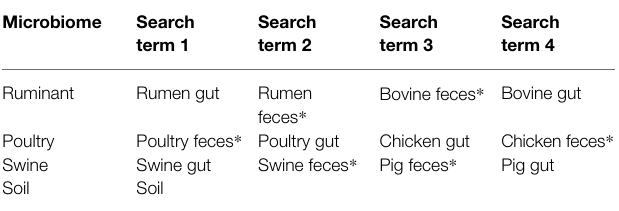
TABLE 1 | NCBI SRA search